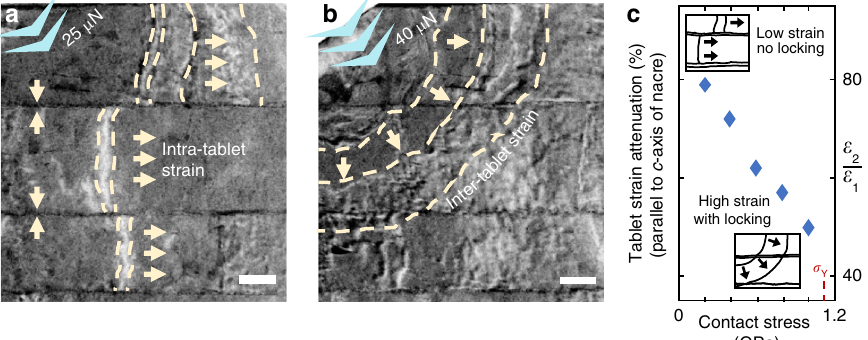
Fig. 2 Strain propagation con fi ned by organic interfaces. a , b Bright- fi eld TEM (with contrast inverted) on the cross-sectional nacreous region under low and high compressive contact stresses. Under low compressive stress, intra-tablet strain contours are generated, and strain propagates independently along each tablet. As the compressive stress is increased, nacre tablets interlock and larger inter-tablet strain contours propagate diagonally between tablets. c Tablet strain attenuation along the axis of the indentation source. The linear strain dissipation behavior indicates that the deformability of nacre is weakened as the applied stress is increased. Scale bar 200